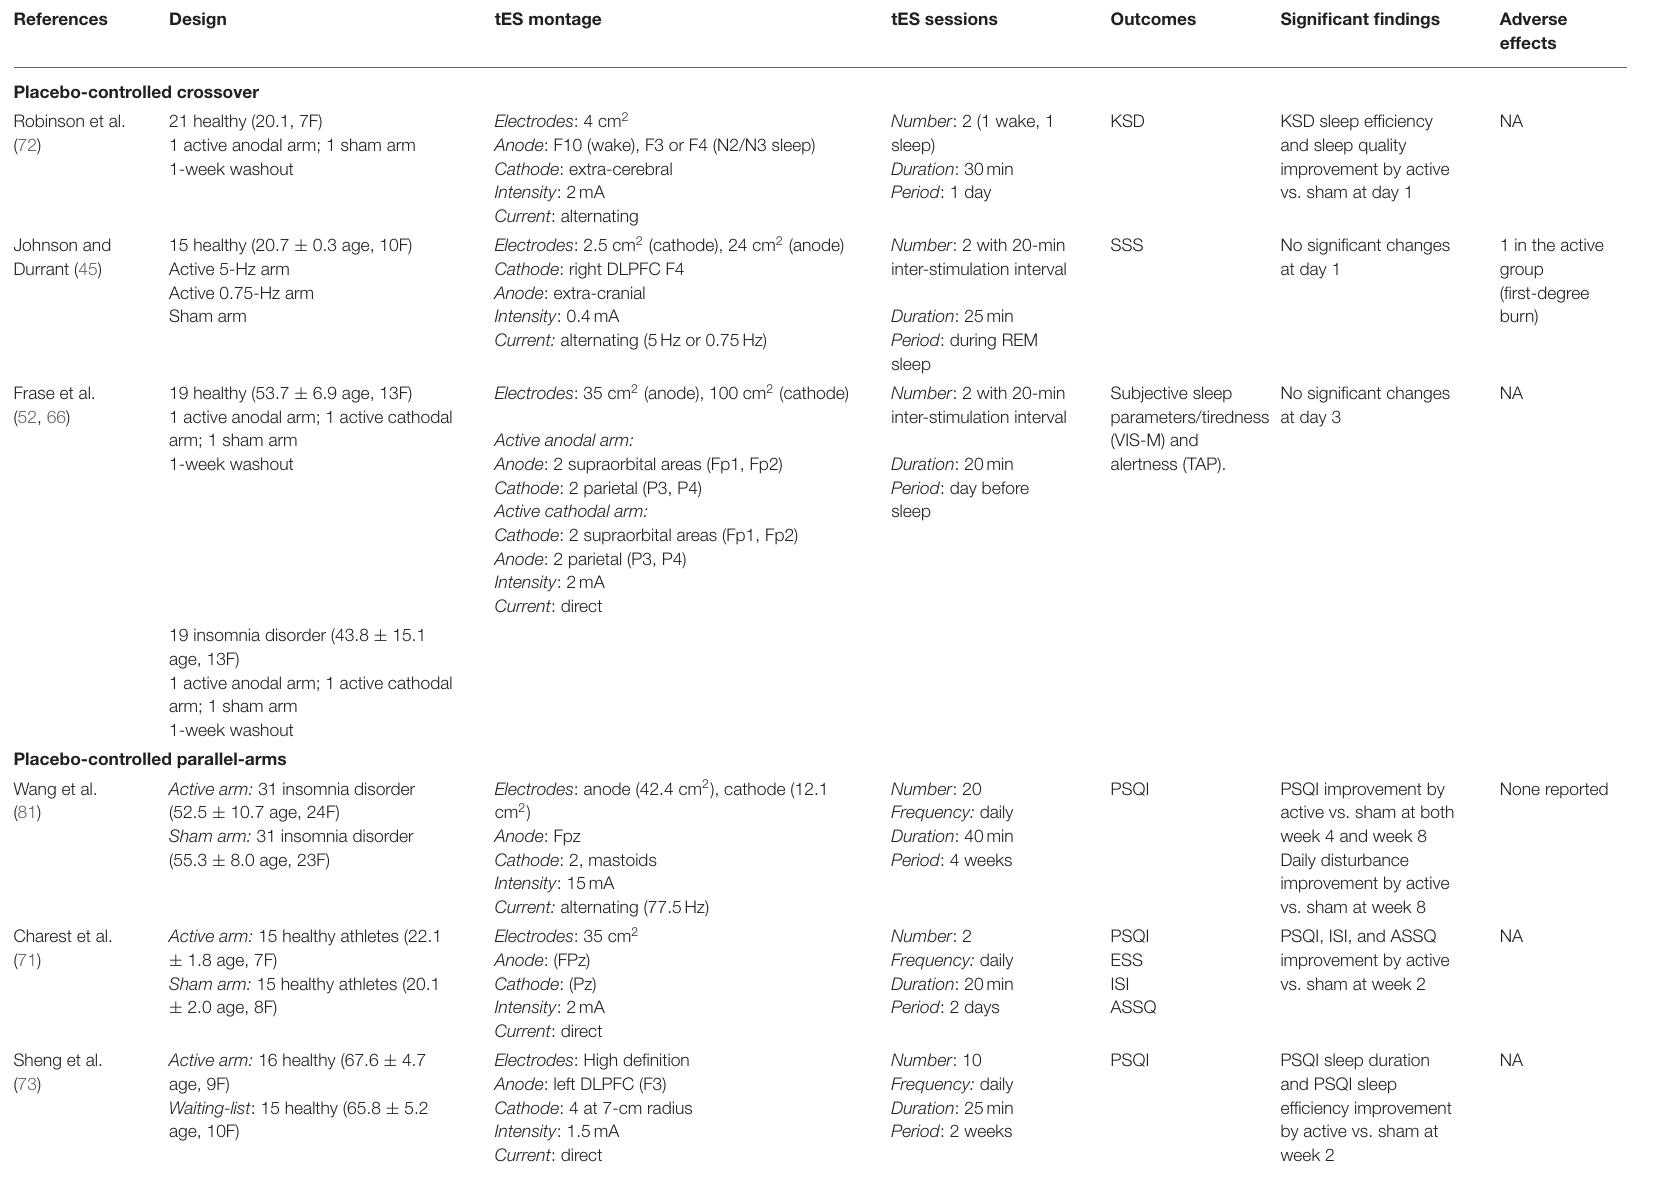
TABLE 3 | Impact of transcranial electrical stimulation on subjective aspects of